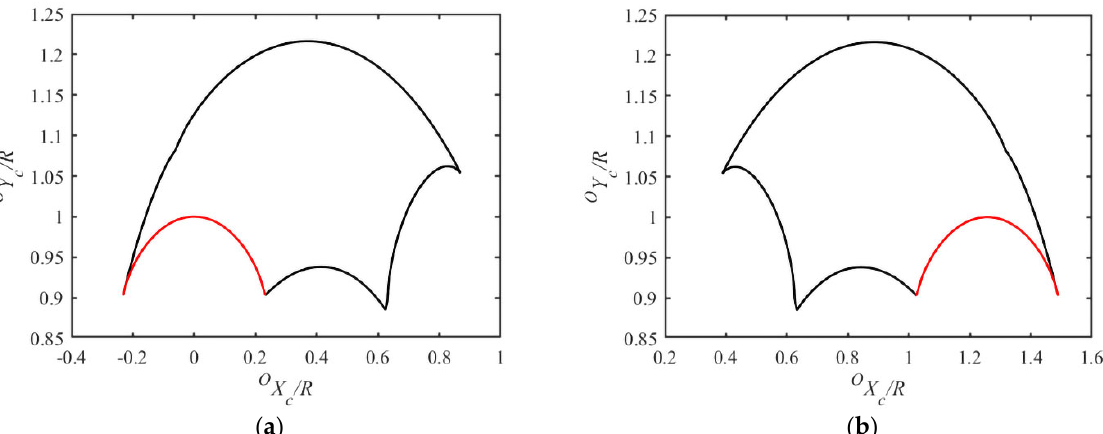
Figure 6. the workspace of the mechanism’s CoM at the initial and end positions. (a) 𝜙 (cid:3404) 0 . (b) 𝜙 (cid:3404) 2 𝜋 /5 . ( b ) φ = 2 π